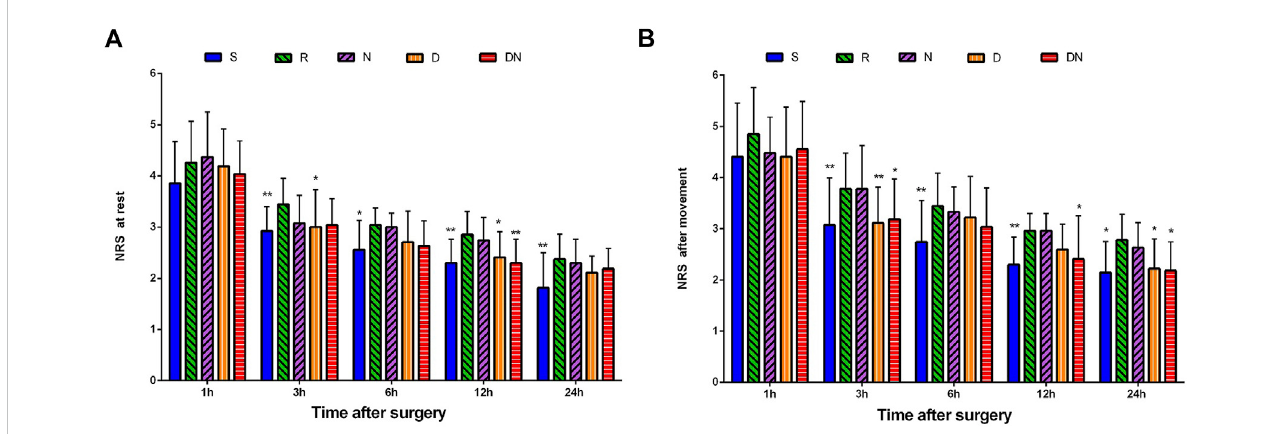
FIGURE 4 Postoperative pain intensity. The numerical rating scale (NRS) score for pain at rest (A) and after movement (B) was documented at 1, 3, 6, 12, and 24 h after surgery. Group S: Intraoperative sufentanil .20 μ g kg − 1 and pre-anesthesia saline; Group R: Intraoperative remifentanil 0.20 μ g kg − 1 min − 1 and pre- anesthesia saline; Group N: Intraoperative remifentanil 0.20 μ g kg − 1 min − 1 and pre-anesthesia nalmefene 0.20 μ g kg − 1 ; Group D: Intraoperative remifentanil 0.20 μ g kg − 1 min − 1 and pre-anesthesia dexmedetomidine 0.50 μ g kg − 1 ; Group DN: Intraoperative remifentanil 0.20 μ g kg − 1 min − 1 and